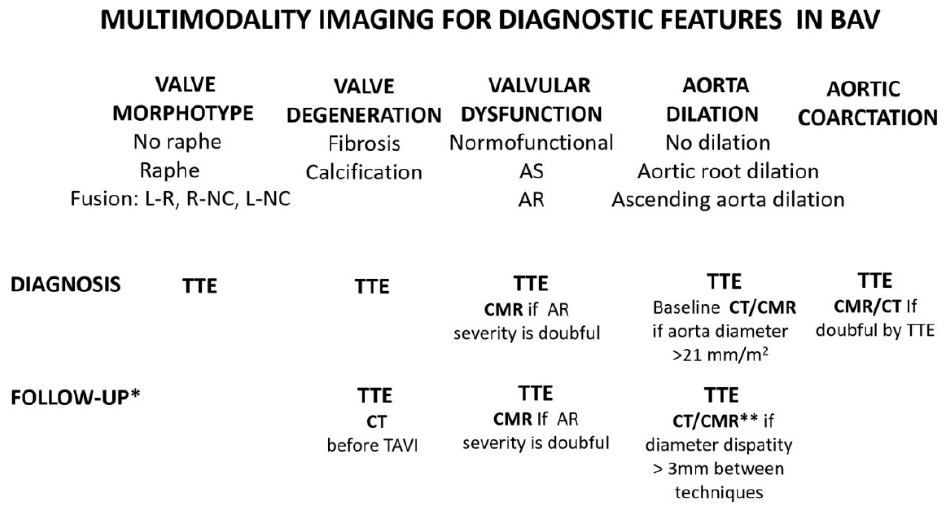
Figure 6. Multimodality imaging for diagnostic and follow-up of features in bicuspid aortic valve patients. * Follow-up depending on the severity of valvular dysfunction and aorta dilation. ** When disparity between TTE and CT/MRI, >3 mm follow-up should be performed annually by TTE and every 3 years by CT/MRI if the maximum diameter is <45 mm, every 2 years if it is between 45–50 mm, and yearly if >50 mm. Abbreviatures: TTE: transthoracic echocardiography, MRI: magnetic resonance imaging; CT—computed tomography; Fusion L-R—left-right sigmoids fusion; R − NC—right − non coronary sigmoids; L − NC— left-non coronary sigmoids. AS—aortic stenosis; AR—aortic regurgitation.